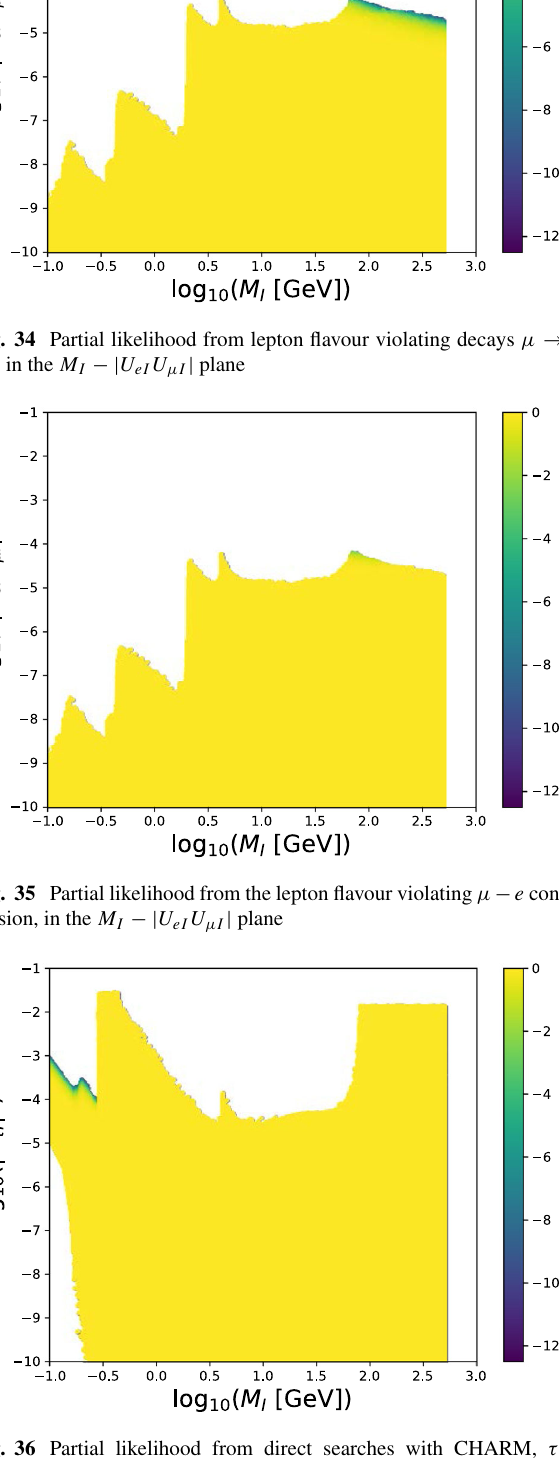
Fig. 36 Partial likelihood from direct searches with CHARM, τ